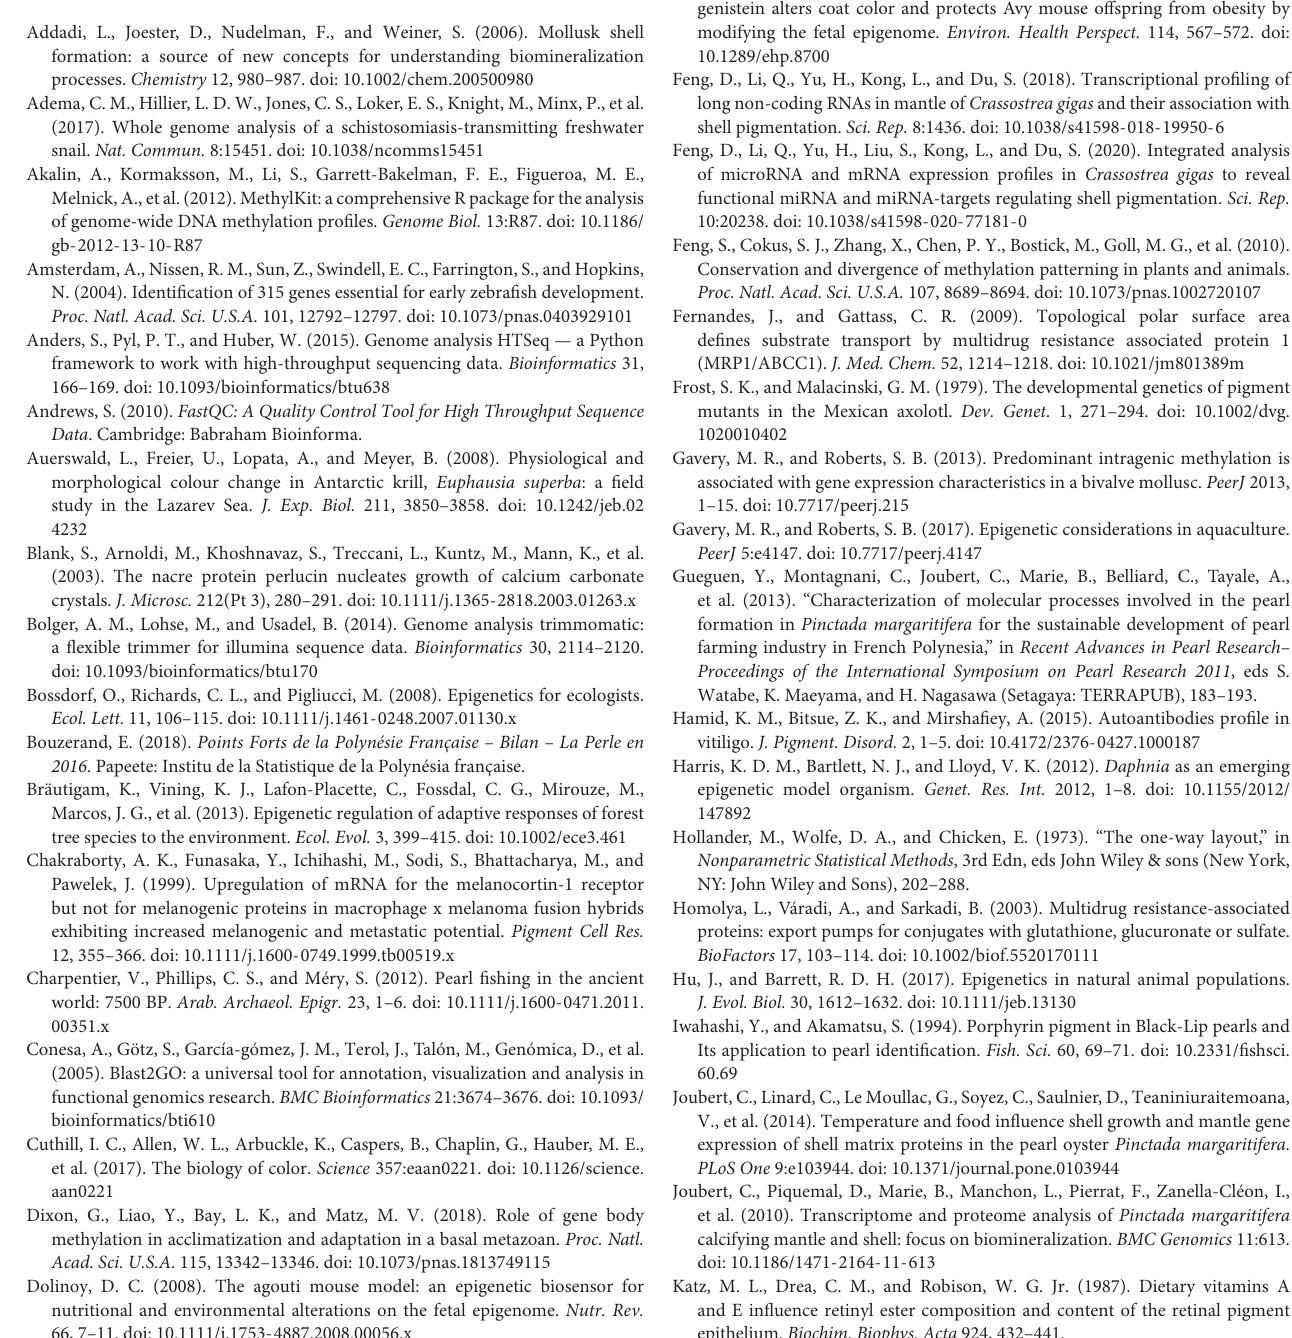
DNA methylation change; q value: q value; Diff-M: the differential methylation level obtained using the Methylkit R package; Gene annotation name: Gene annotation according to the nr and swiss-prot blast top hit. Blue shading (negative values) indicates hypomethylation of the position and red shading (positive values) hypermethylation; darker shading indicates a stronger degree of hypomethylation of hypermethylation, respectively. The last column indicates in which comparison the significantly different methylated positions were